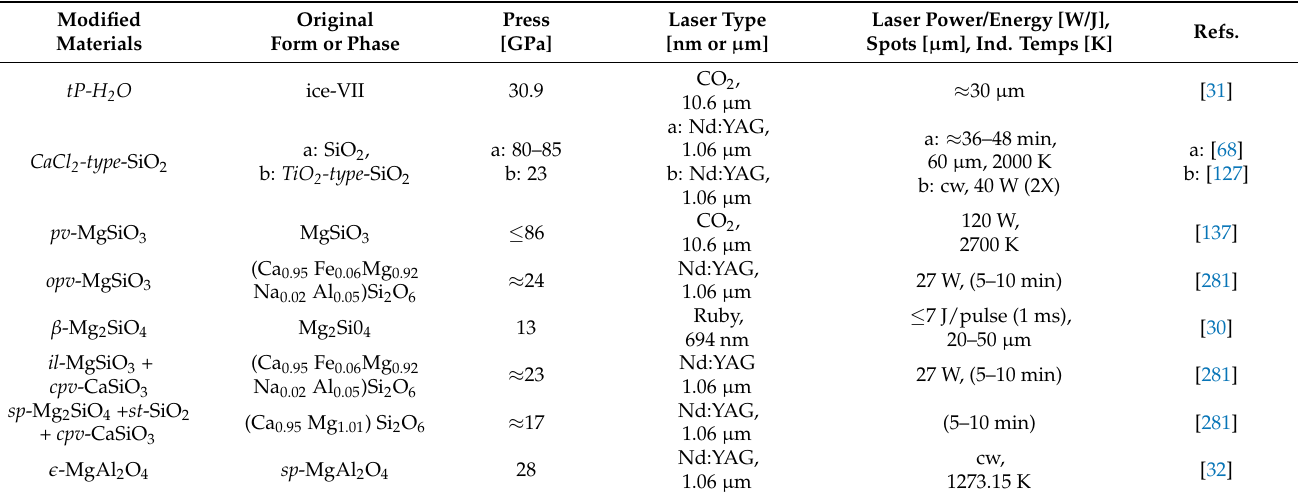
Table 4. Physical processes and experimental parameters of geological/planetary minerals produced in selected LH-DAC